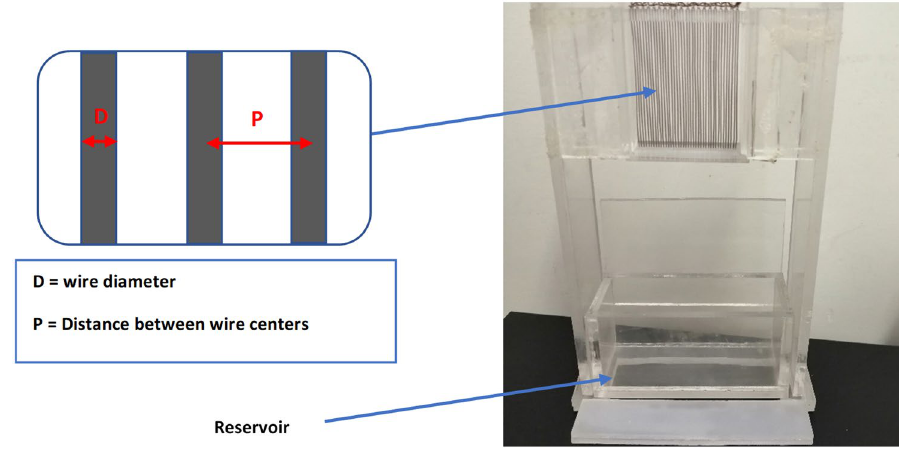
Fig. 2 The fog droplets’ cap- ture and collection section of the fog harvesting